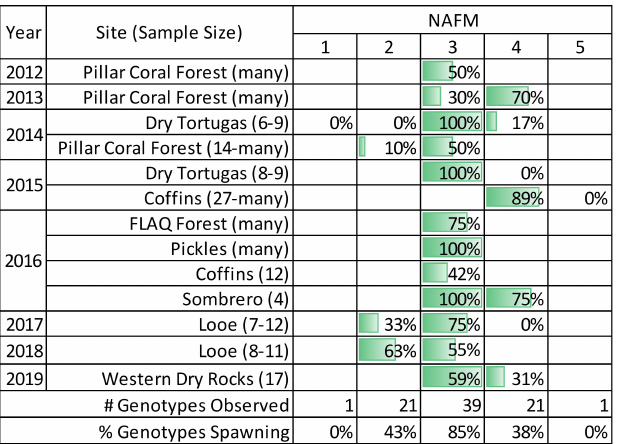
to genotype based on identification tags. For some genotypes, multiple fragments were observed. For each spawning event, observers recorded fragment genotype, date, time of spawning, and